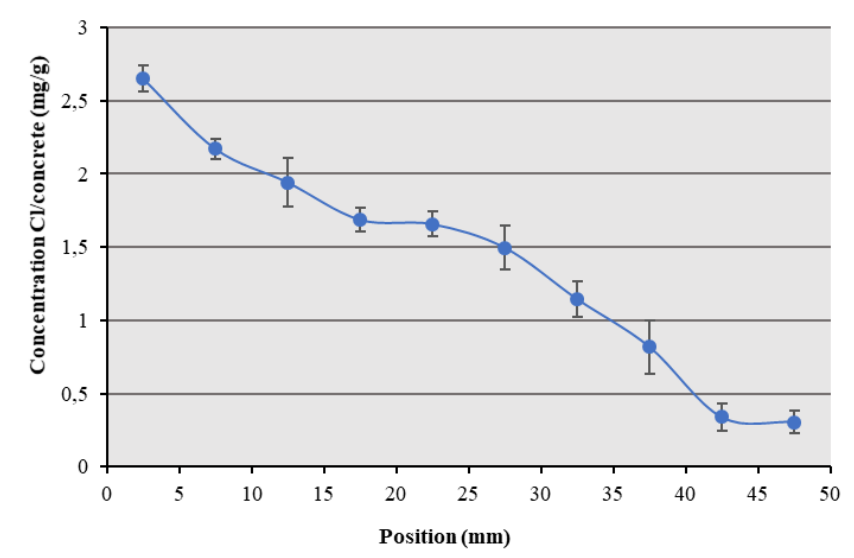
Figure 3. Concentration profile in L